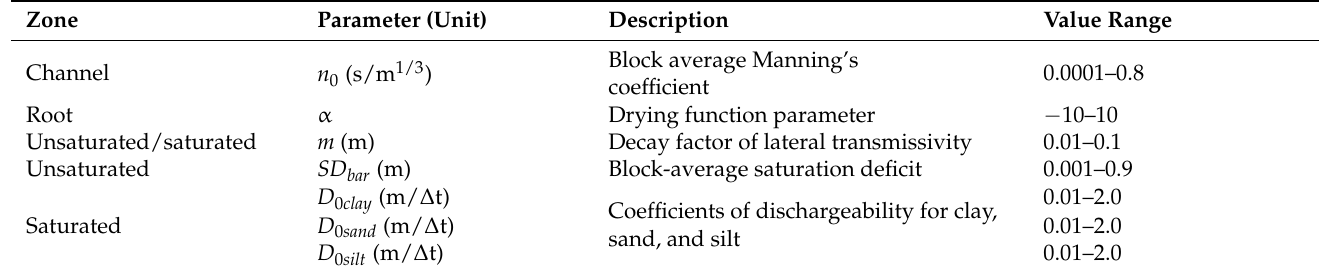
Table 3. The summary of parameter information for the BTOP